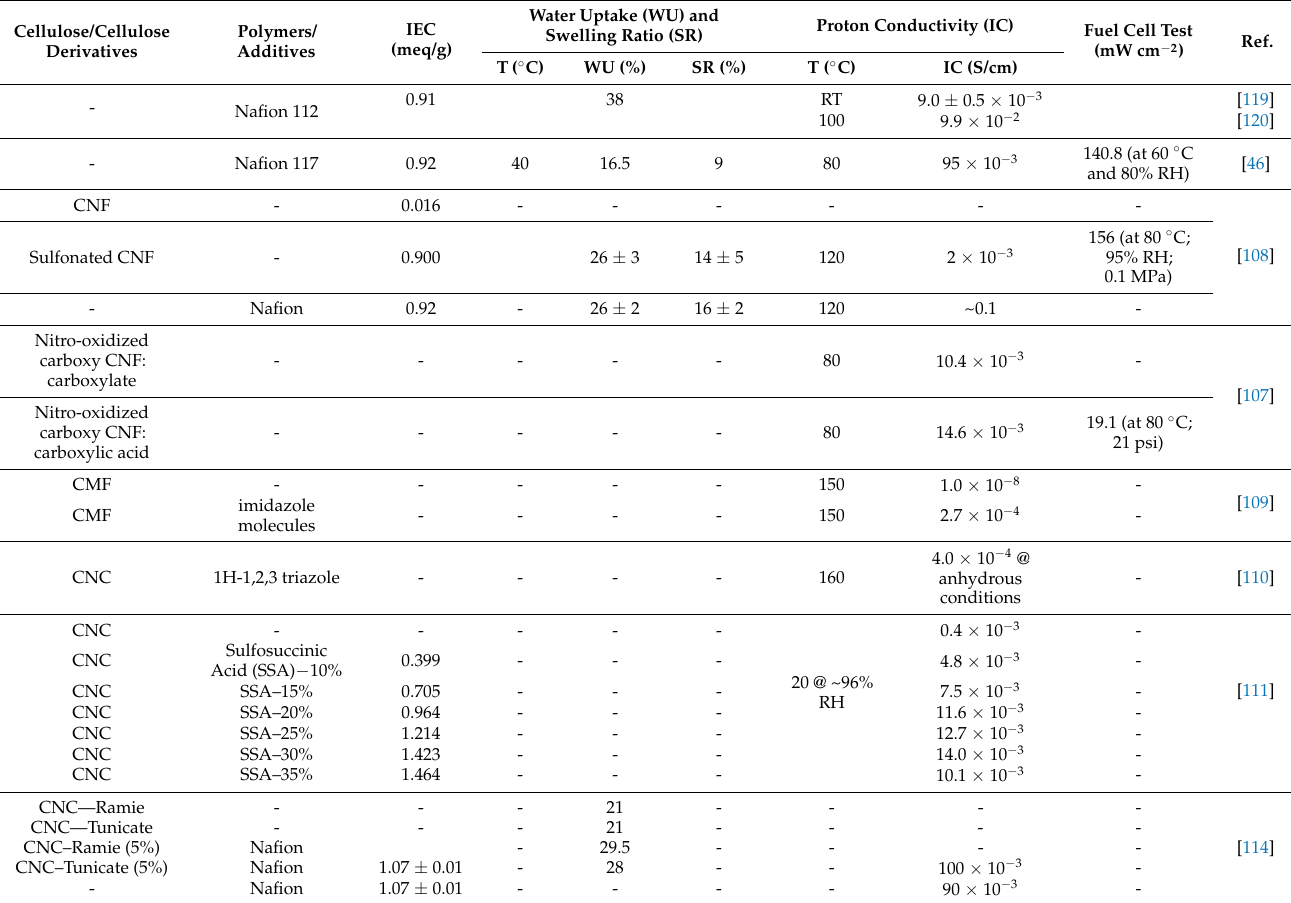
Table 1. Physicochemical and unit cell performance results of different kinds of cellulose-containing membranes for PEMFC